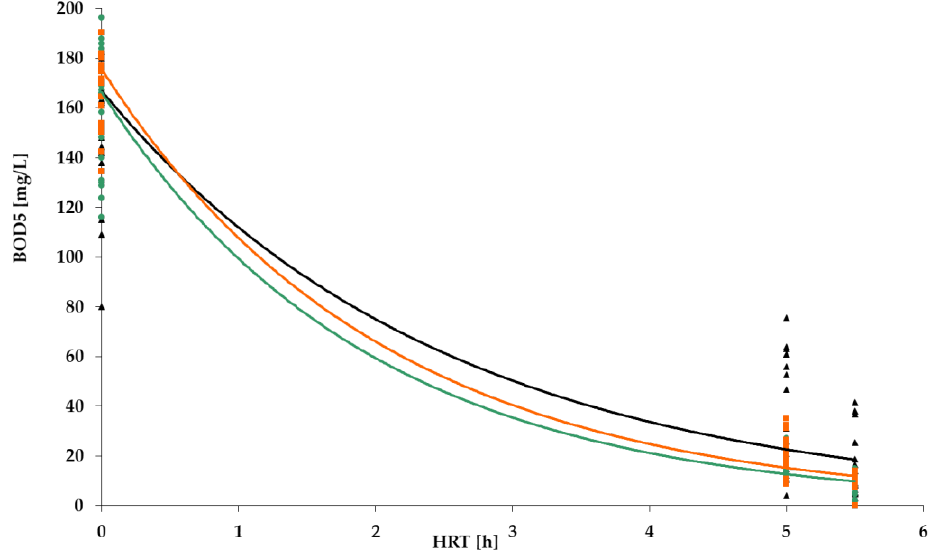
Figure 9. BOD removal dynamics for: PS floating carrier (black); PV floating carrier (green); BB floating carrier (orange).